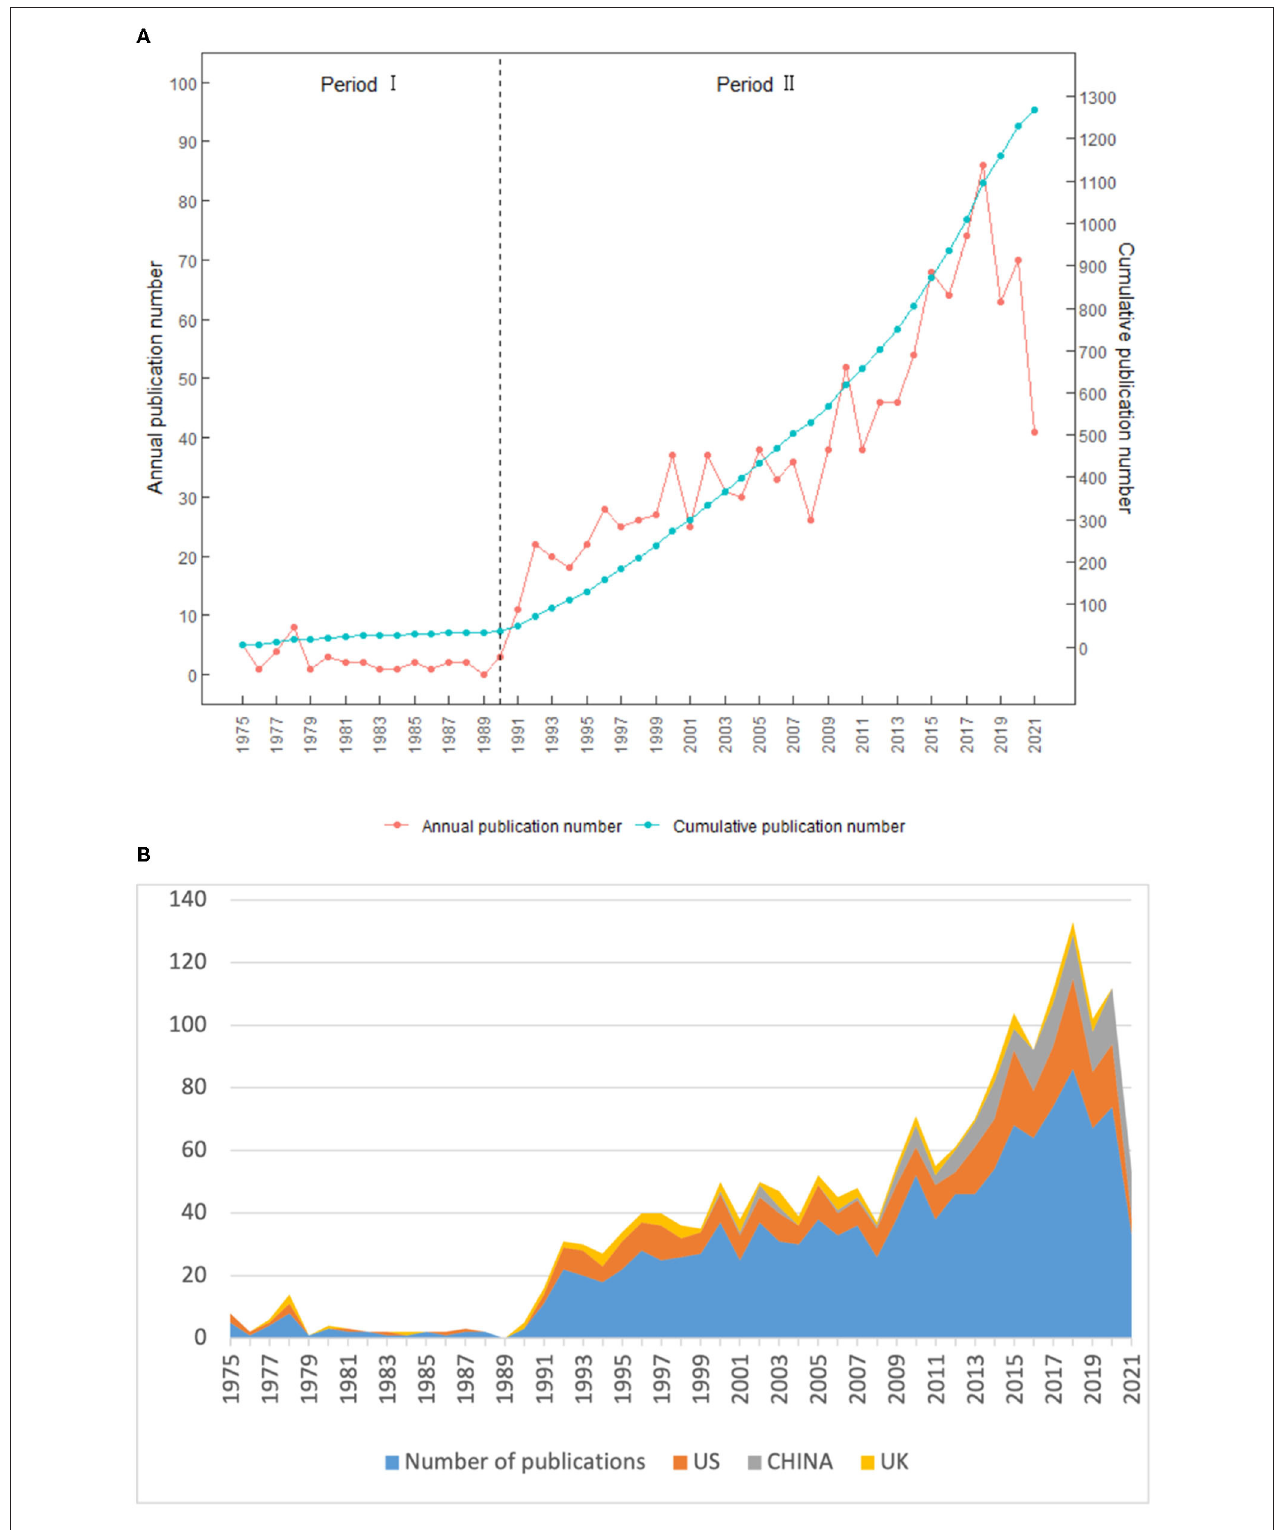
FIGURE 2 | (A) Number of publications by year. (B) Number of publications by year of US, China, and UK.